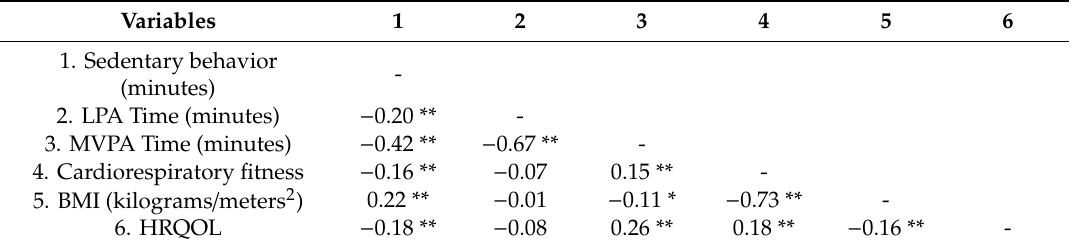
Table 2. Pearson product–moment Correlation among the study variables (N =